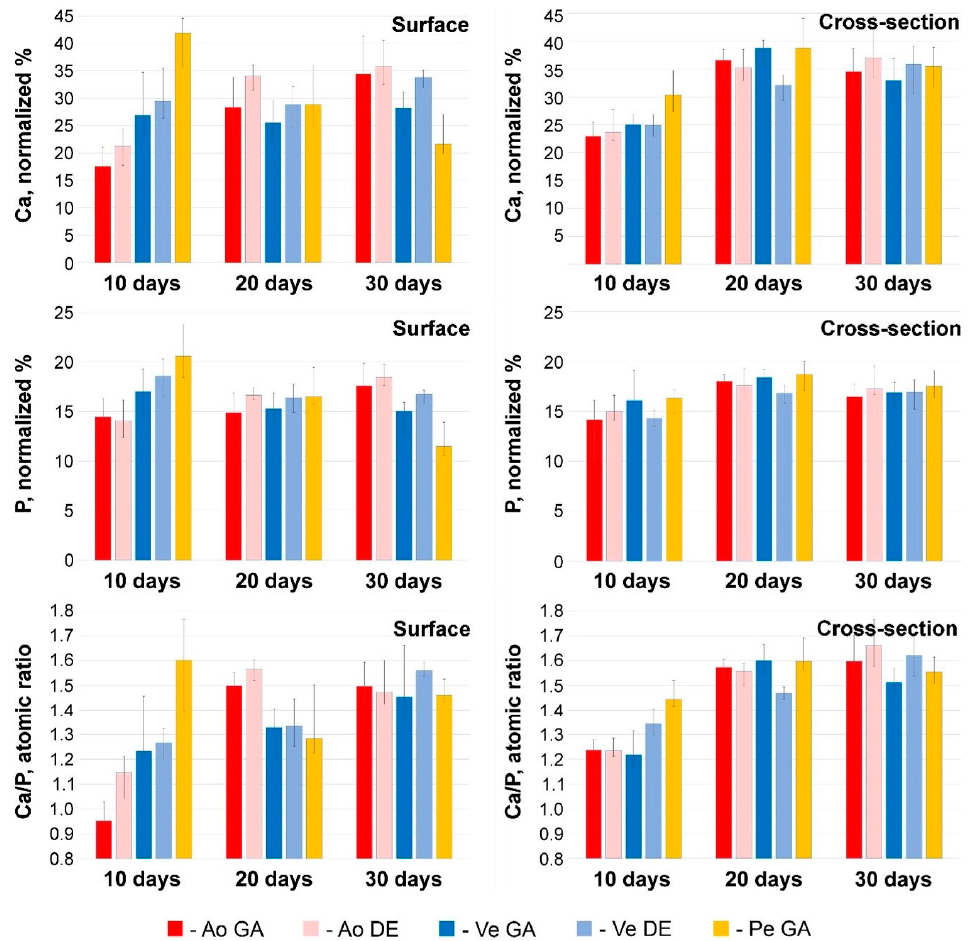
Figure 4. Results of EDS analysis at 10, 20, and 30 days after implantation. Ca and P content (normalized %) and Ca/P atomic ratios in electron-dense conglomerates located on the surface and in deep layers of tissue samples. Color labeling of biomaterials is similar to Figure